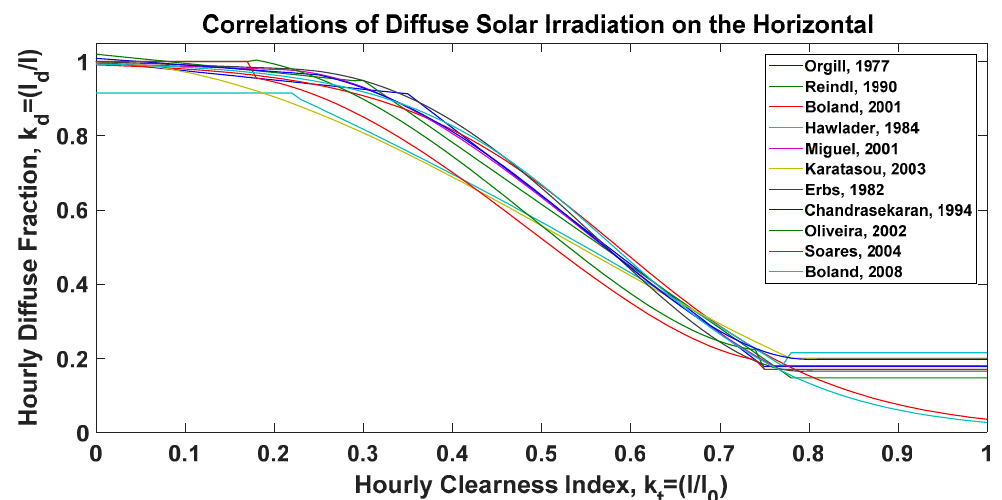
Figure 3. Different correlations of the diffuse solar irradiation on the horizontal surface proposed in the literature.